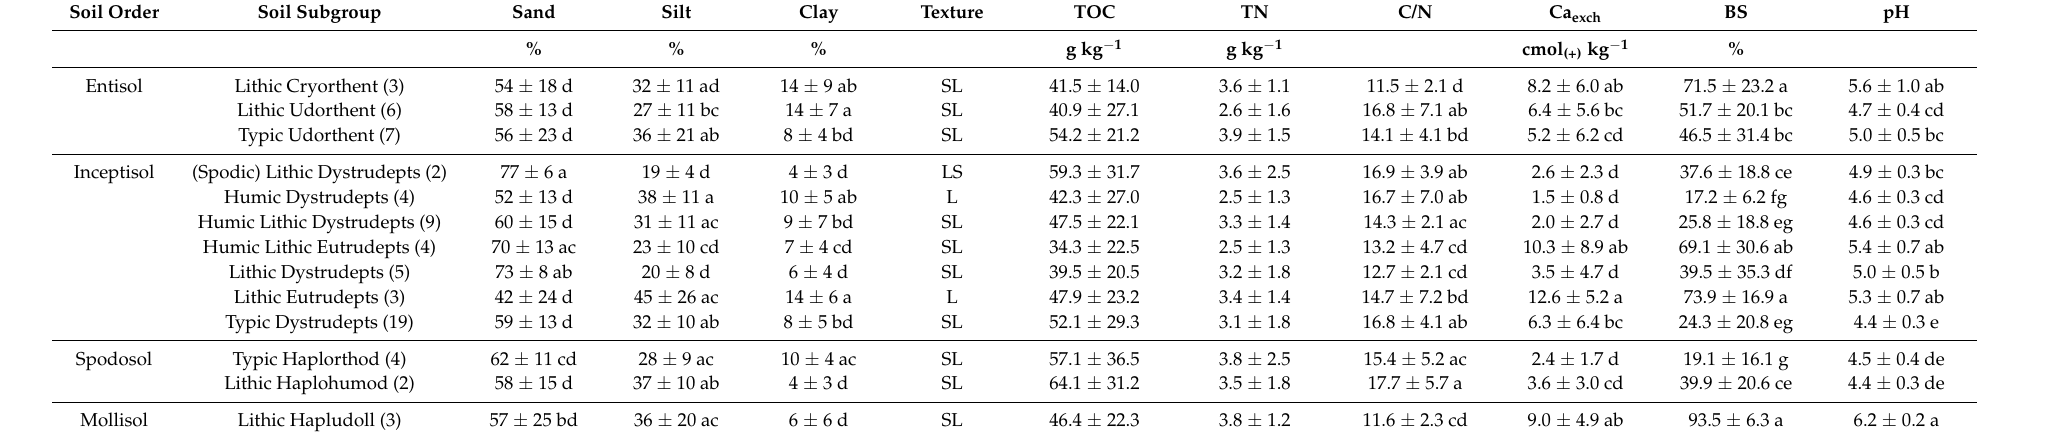
SL is sandy loam; L is loam; SiL is silty loam; SCL is sandy clay loam. Table 4. Mean ± standard deviation of sand, silt, clay, total organic carbon (TOC), total nitrogen (TN), and exchangeable Ca (Ca exch ) contents, base saturation (BS), and pH values, and texture class soils identified within the 1000–2134 m above sea level altitudinal range and classified according to Soil Survey Staff [52]. Round brackets indicate the number of soil profiles identified for each soil type. Within each column, different letters indicate significant differences among the values (Kruskal–Wallis test, p <